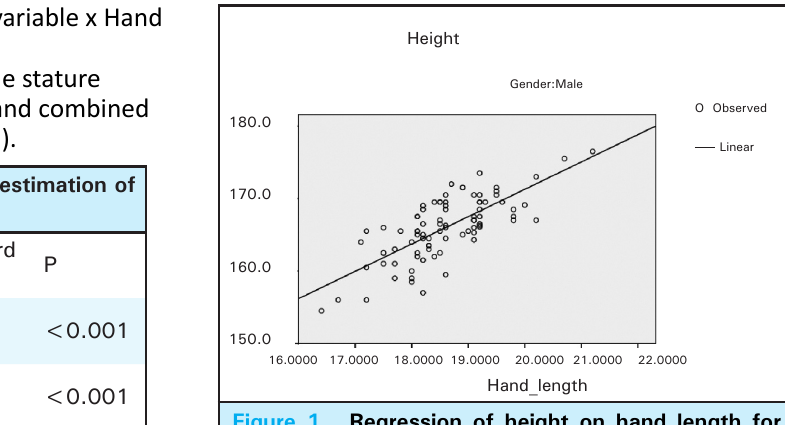
Figure 1. Regression of height on hand length for